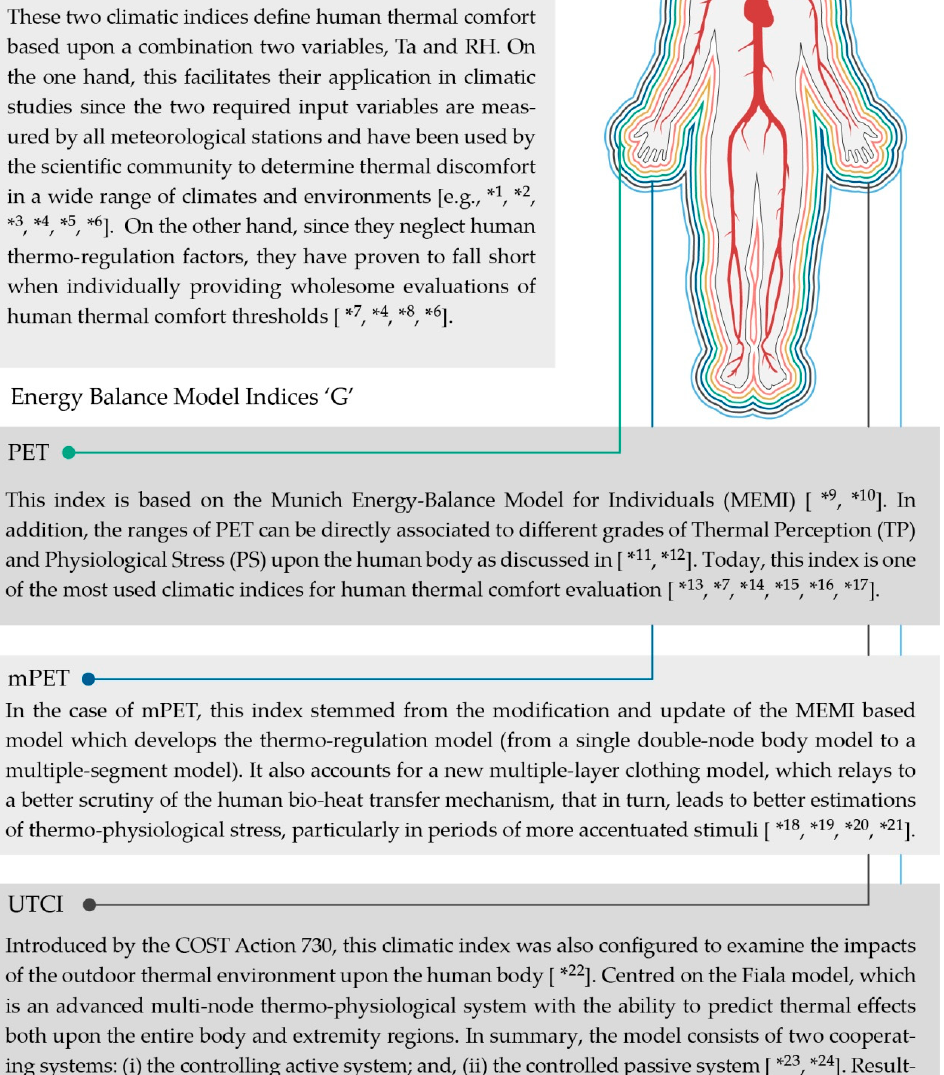
Figure 1. Descriptive summary of employed climatic indices utilized for human thermal comfort assessments. Figure references: 1 [58], 2 [59], 3 [60], 4 [61], 5 [62], 6 [63], 7 [41], 8 [64], 9 [65], 10 [9], 11 [11], 12 [66], 13 [67], 14 [25], 15 [68], 16 [69], 17 [70], 18 [71], 19 [57], 20 [72], 21 [73], 22 [74], 23 [75], 24 [76], 25 [77], 26 [78], 27